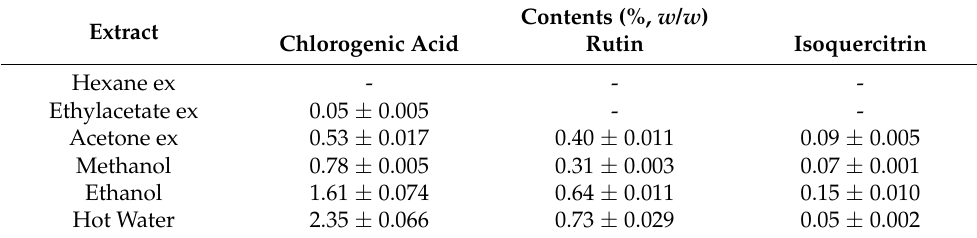
Table 2. Contents of three biomarkers from IW leaf extracts.